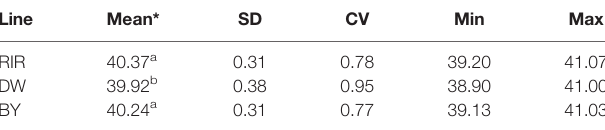
TABLE 1 | Early body temperature in three study